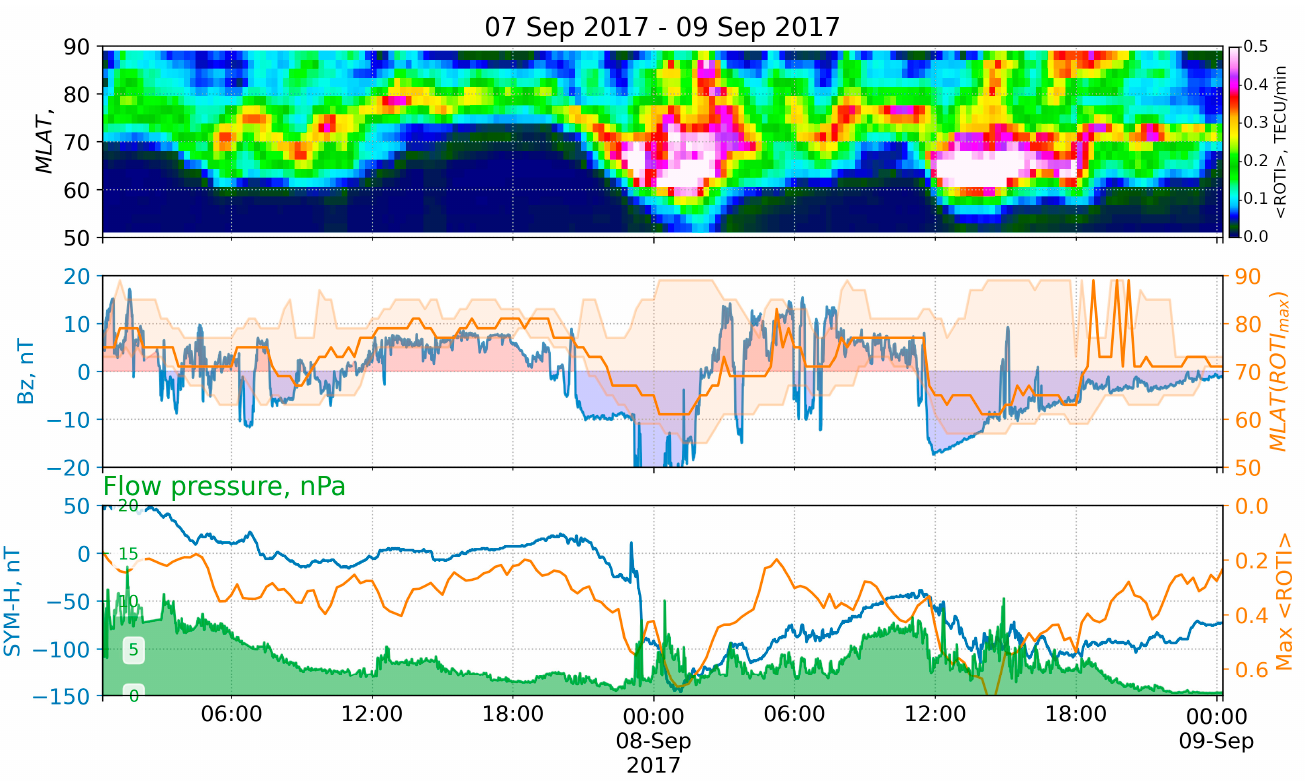
Figure 12. ROTI keogram and space weather parameters for the storm of 7–8 September 2017: ( top ) keogram of average ROTI (<ROTI> versus MLAT versus time); ( middle ) IMF Bz ( blue ), MLAT positions of maximum <ROTI> ( orange ), and values exceeding median ROTI at the moment ( orange filling ); ( bottom ) SYM-H index ( blue ), <ROTI> max ( orange ), and flow pressure ( green ).